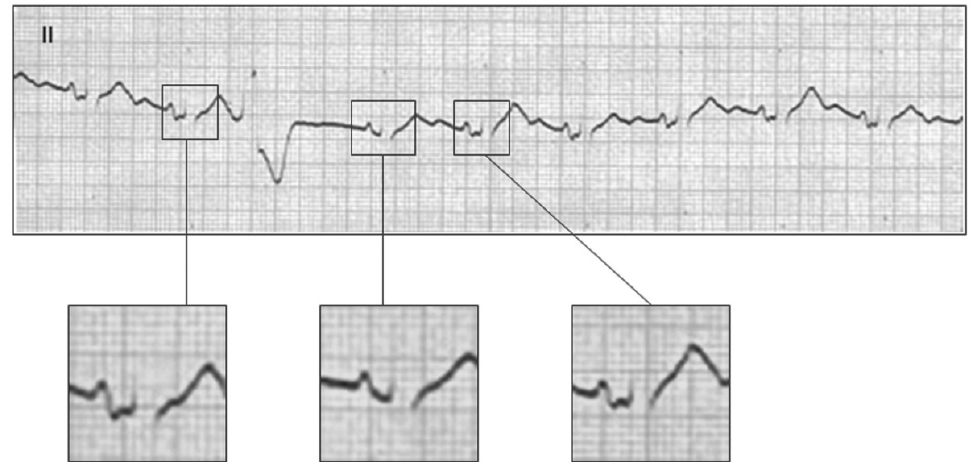
Figure 12. Lead II ECG strip from an 82-year-old man with frequent PVCs. The first two beats show typical advanced IAB (P-wave in lead II is biphasic, with P-wave duration >120 ms). After the premature ventricular contraction (PVC), there is a pause followed by a P-wave of normal duration and morphology. The next P wave again depicts advanced IAB. This case serves as an example of second degree IAB induced by a pause after a